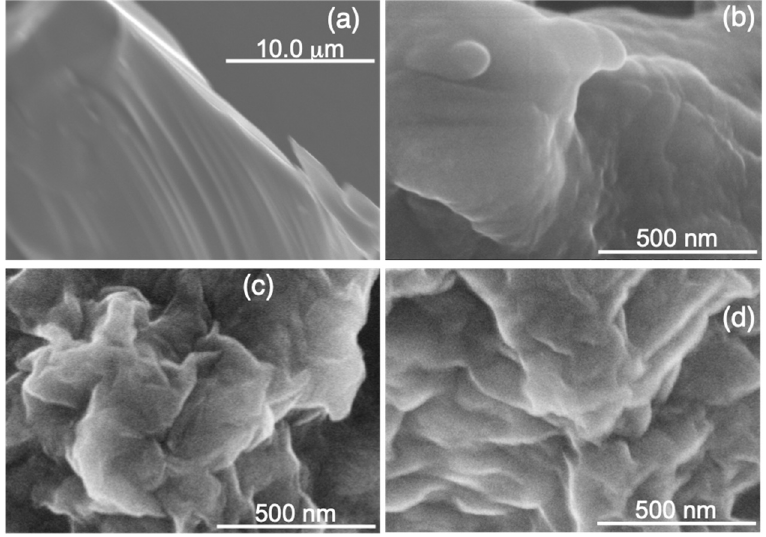
Figure 1. SEM images of polyFe/LIIm composites ( a ) 3/0.1, ( b ) 3/0.5, ( c ) 3/1, and ( d )